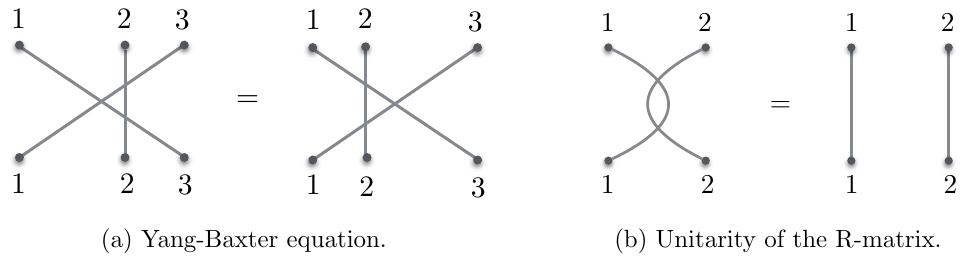
Figure 5. Relations satis(cid:12)ed by the